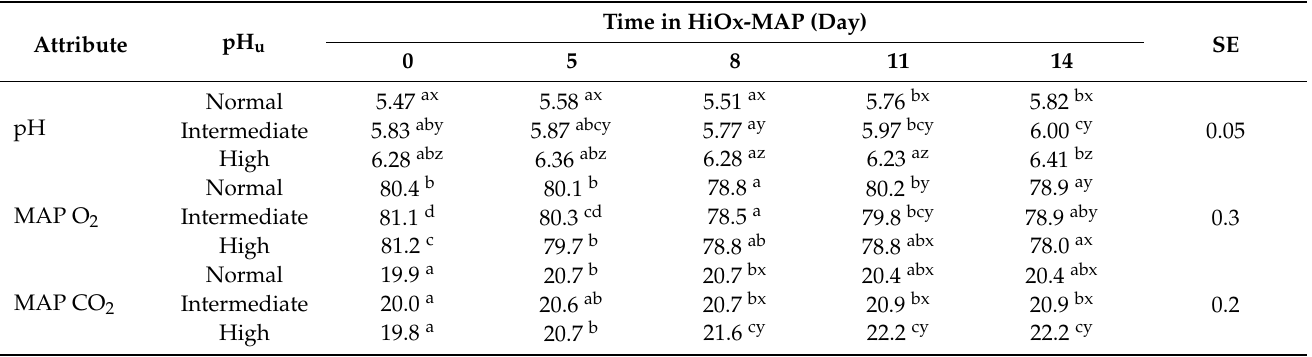
Table 2. Effects of ultimate pH (pH u ) and storage and display time on meat pH and gas composition of Nellore Longissimus lumborum steaks packaged in